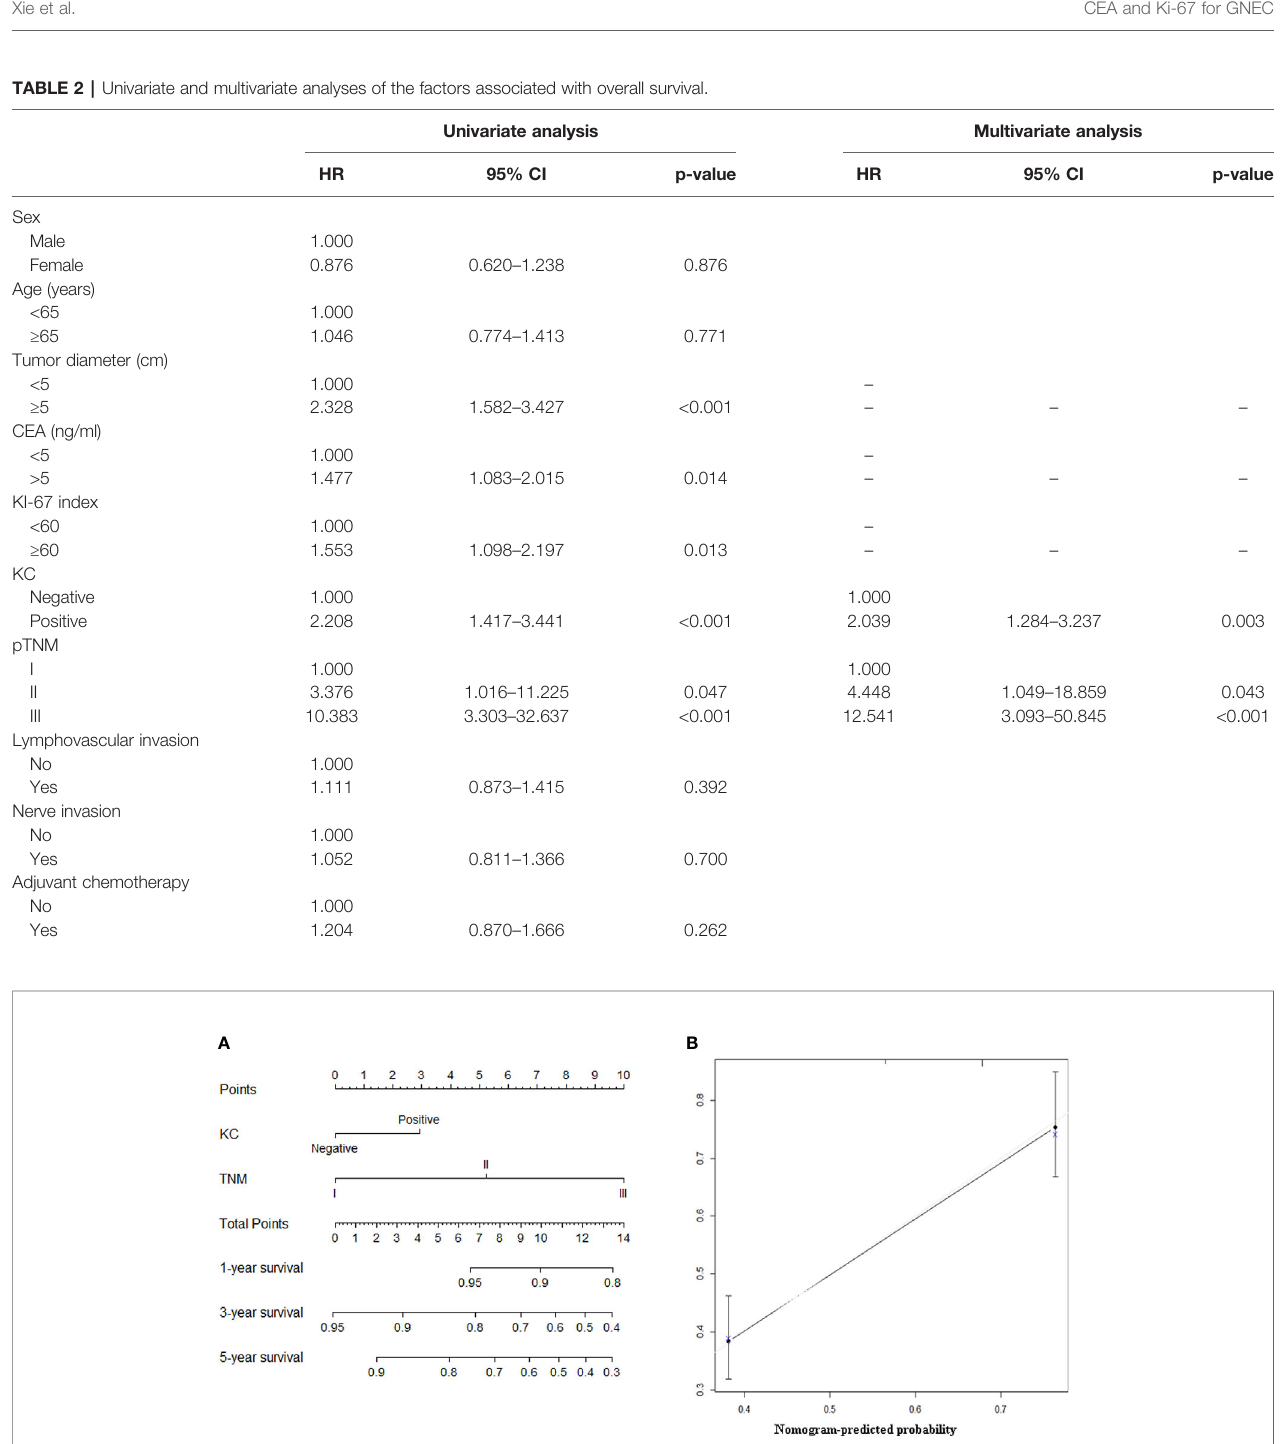
FIGURE 3 | (A) The nomogram predicting overall survival of patients with gastric neuroendocrine carcinoma (GNEC). (B) The calibration curve of the nomogram for the training